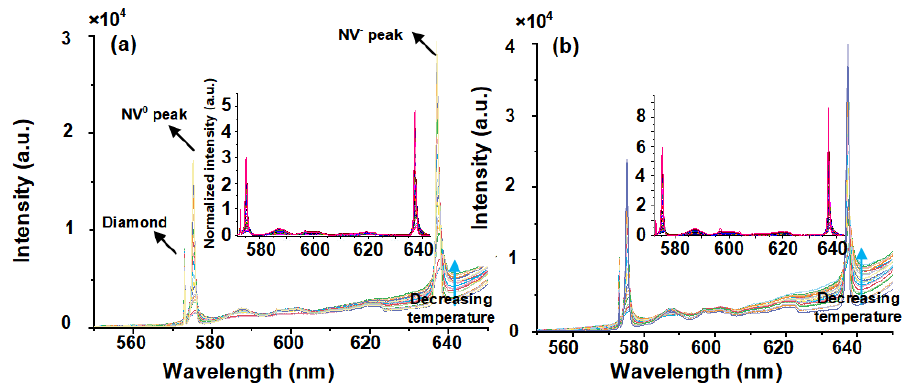
Figure 4. Photoluminescence spectra of samples with ( a ) planar and ( b ) nanocone surfaces range from room temperature to 80 K, respectively. Insets: normalized and baseline spectra of planar and nanocone samples, respectively.